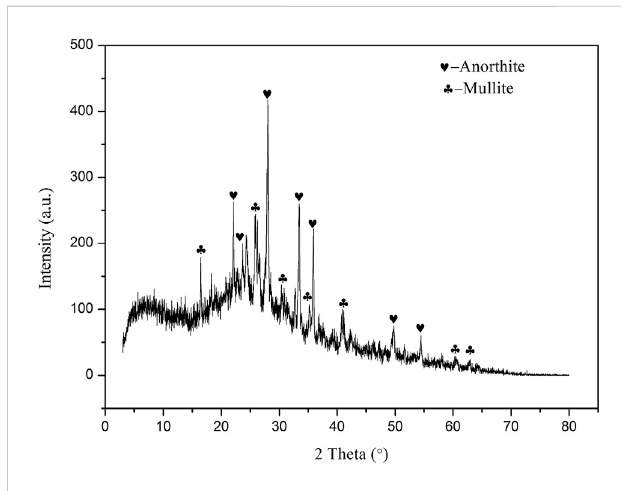
FIGURE 6 XRD pattern of body-glaze intermediate layer of sample